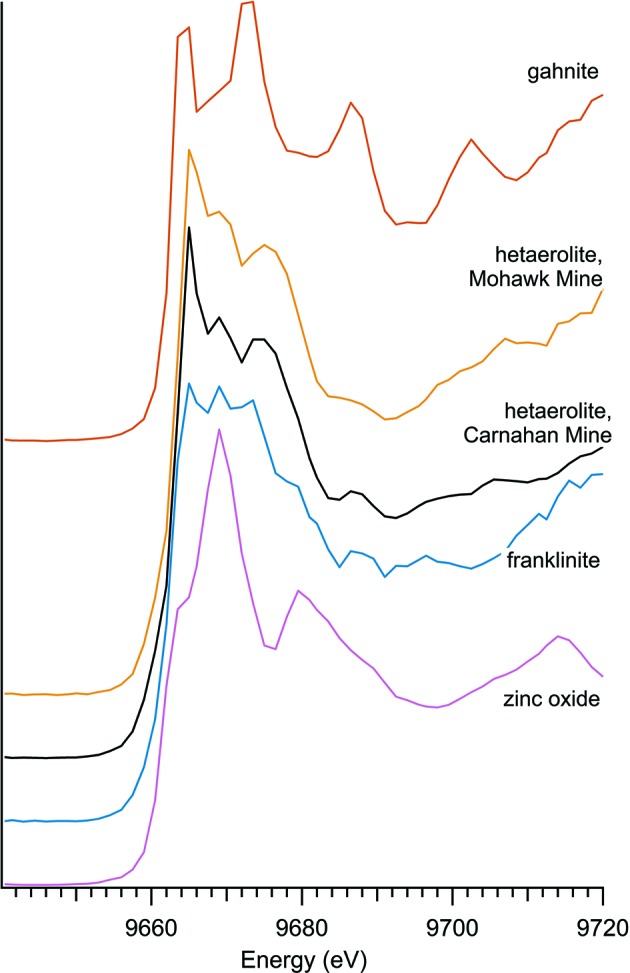
Spectra of zinc oxides.